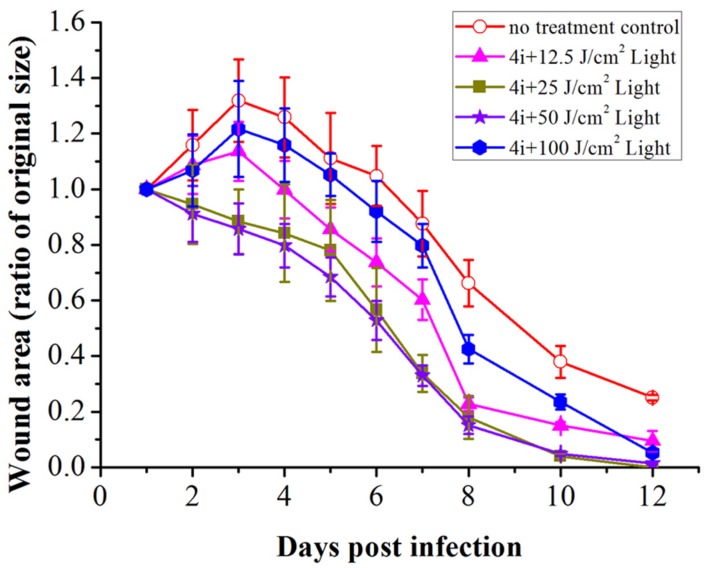
Wound healing ratio over time in bacterial infected rats with and without 4i-PACT. Each point represents the mean ratio of the area of the original wound. Data is expressed as mean ± SEM. N = 6 in each group.